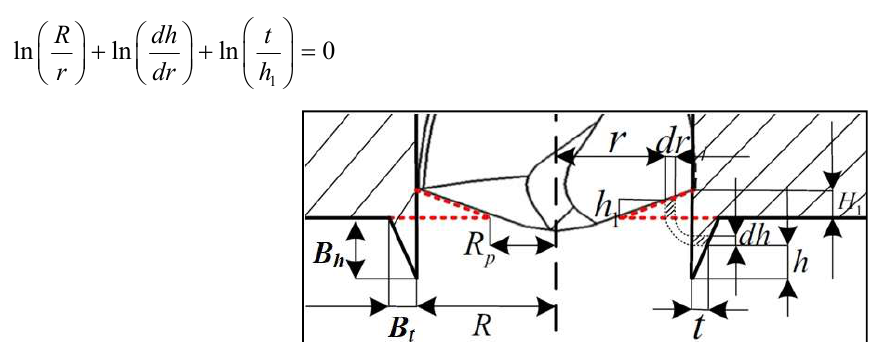
Fig. 6. Exit burr formation and